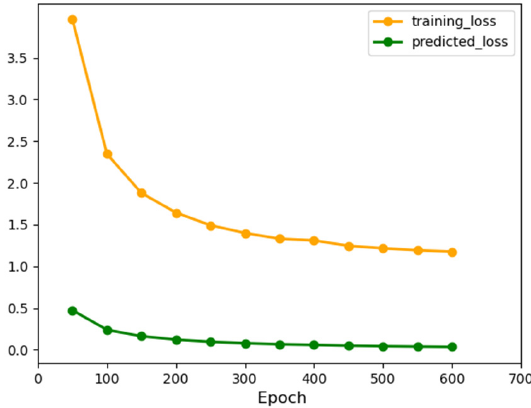
Figure 6. Convergence curve for NURCNet.